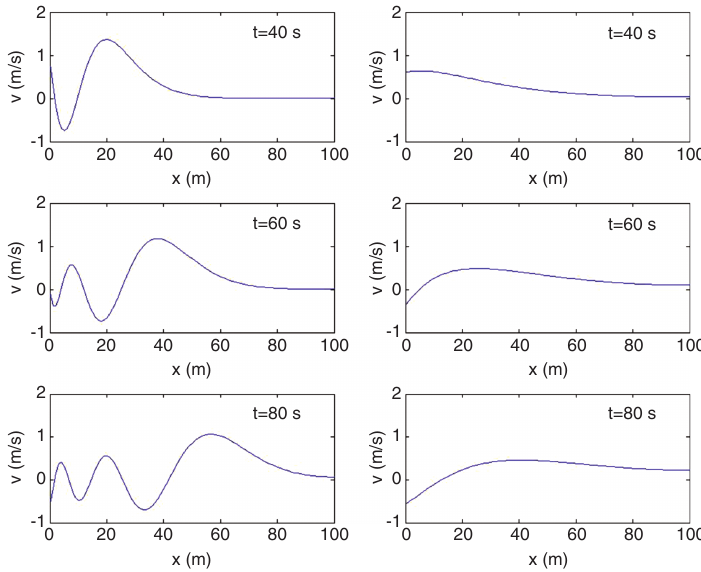
Figure 2 Wave propagation along bar for ℓ = 4 m (left) and ℓ = 16 m